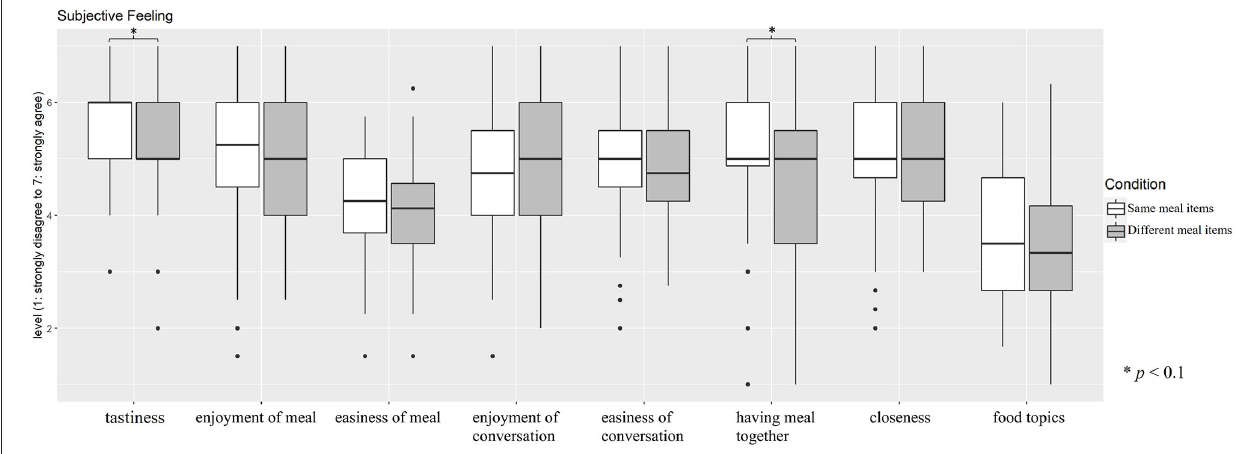
FIGURE 9 | Subjective feelings of tastiness, enjoyment of meal, ease of meal, enjoyment of conversation, ease of conversation, having a meal together, closeness, and food topics (1: strongly disagree ; 7: strongly agree ).